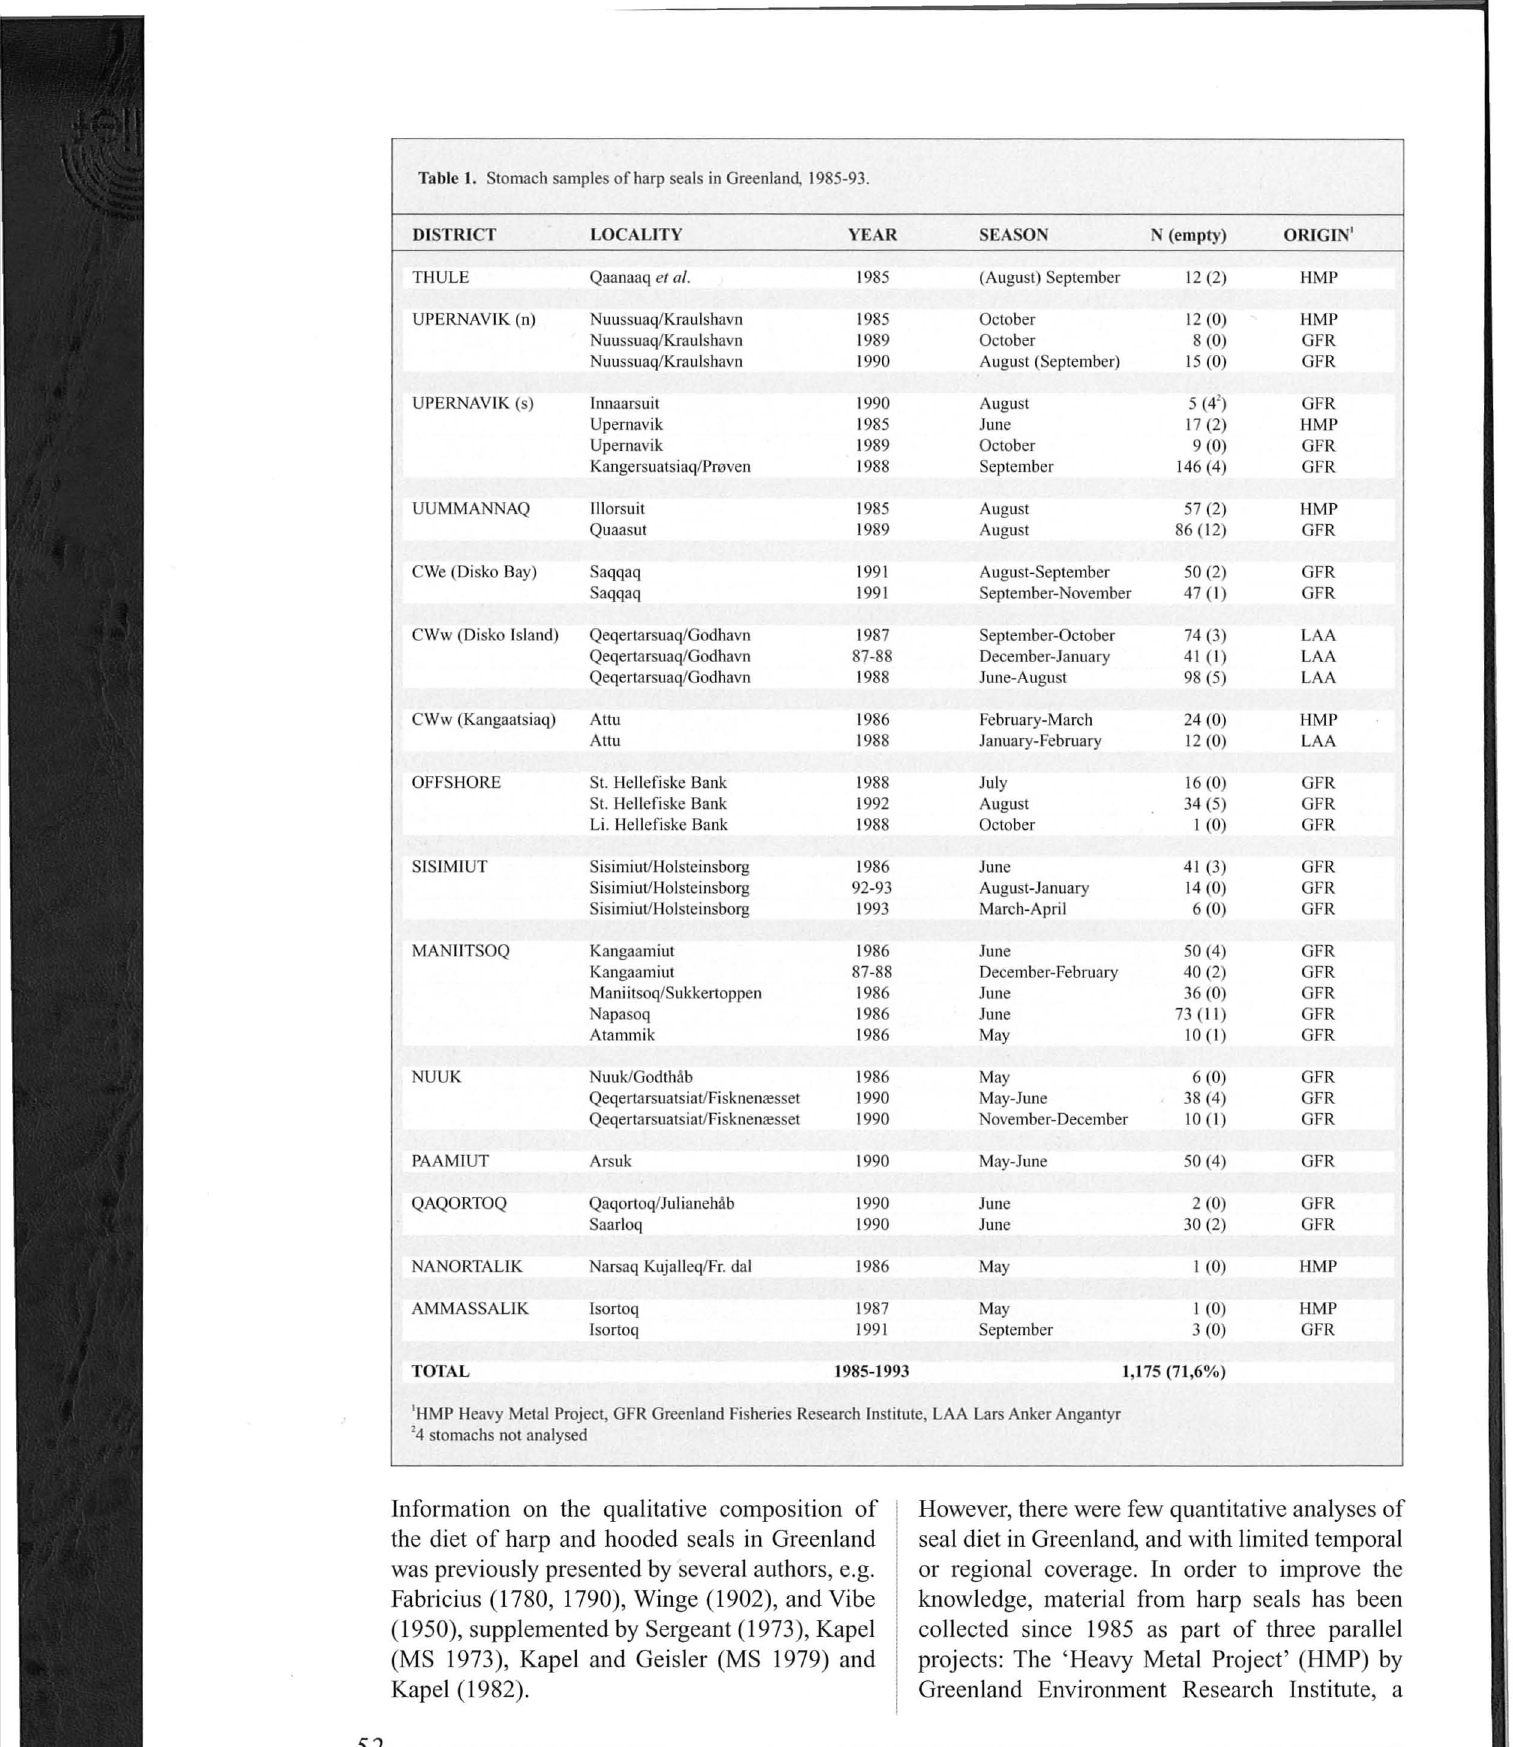
Table I. Stomach samples of harp seals in Greenland, 1985-93. D1STRJCT